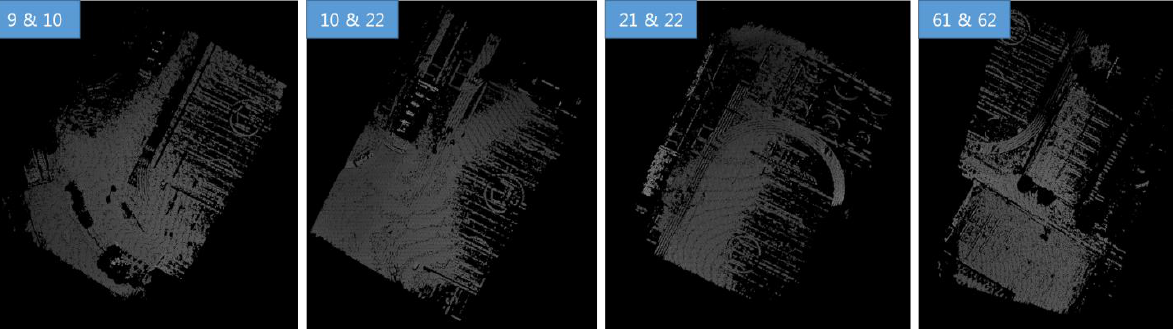
Figure 9. Example of Point cloud results using image space-based matching (each stereo pair results)